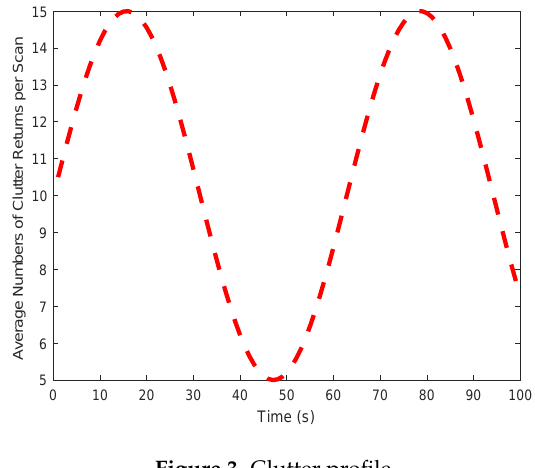
Figure 3. Clutter